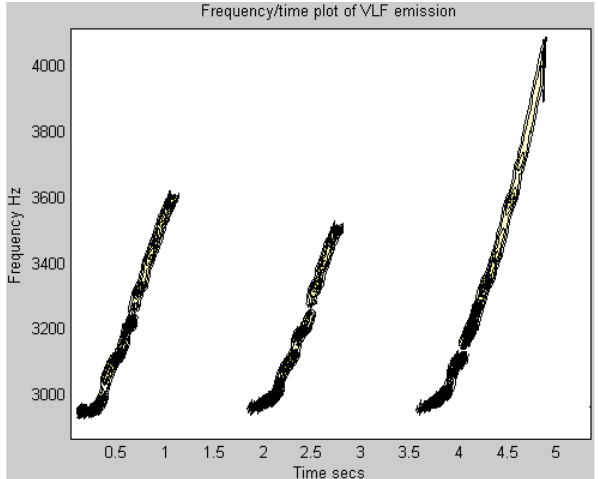
Fig. 21. Simulated lower band rising chorus sequence for a cold plasma density of Ne=191 electrons/cc. The linear growth rate is lower than the previous case at a value 160dB/s, which favours riser generation. There is considerable variability in element structure and